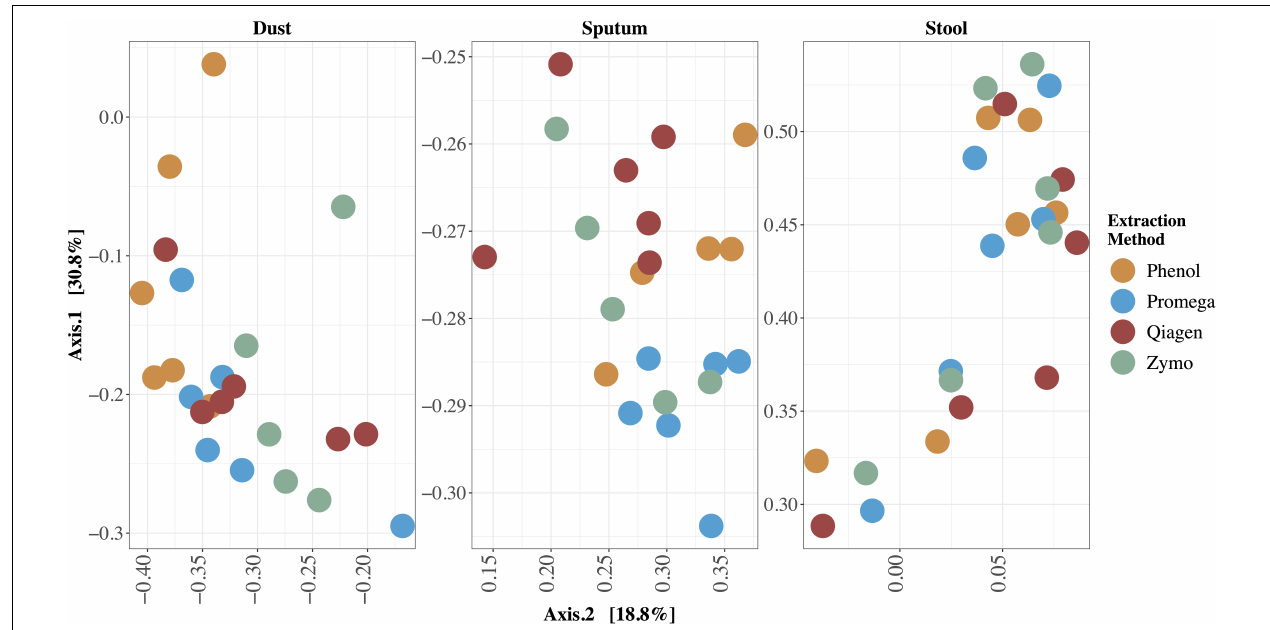
FIGURE 4 | Principal Coordinates Analysis (PCoA) of differences in beta diversity between samples. Bray-Curtis dissimilarity was used to calculate beta diversity. Each dot represents one sample and each color represents one extraction method. Each sample is labeled with the sample identifier. In this type of visualization, samples with more similar microbial community structure cluster together whereas those with more dissimilar microbial community structure are a further distance apart. The effect of extraction method on resulting microbial community profiles differed by sample type; this effect was largest in dust and smallest in stool.